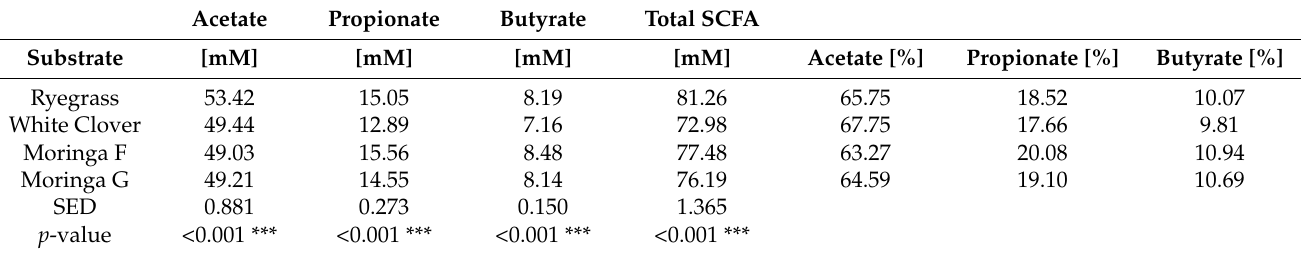
Table 4. Short chain fatty acids at the end of fermentation. Moringa F and G are the mean for M. oleifera samples, F1, F2, F3 and G1, G2 and G3 respectively. Acetate, propionate and butyrate are presented along with total short chain fatty acids. The mean concentration in millimoles (mM), average standard error of the differences (SED) and p -value are presented.